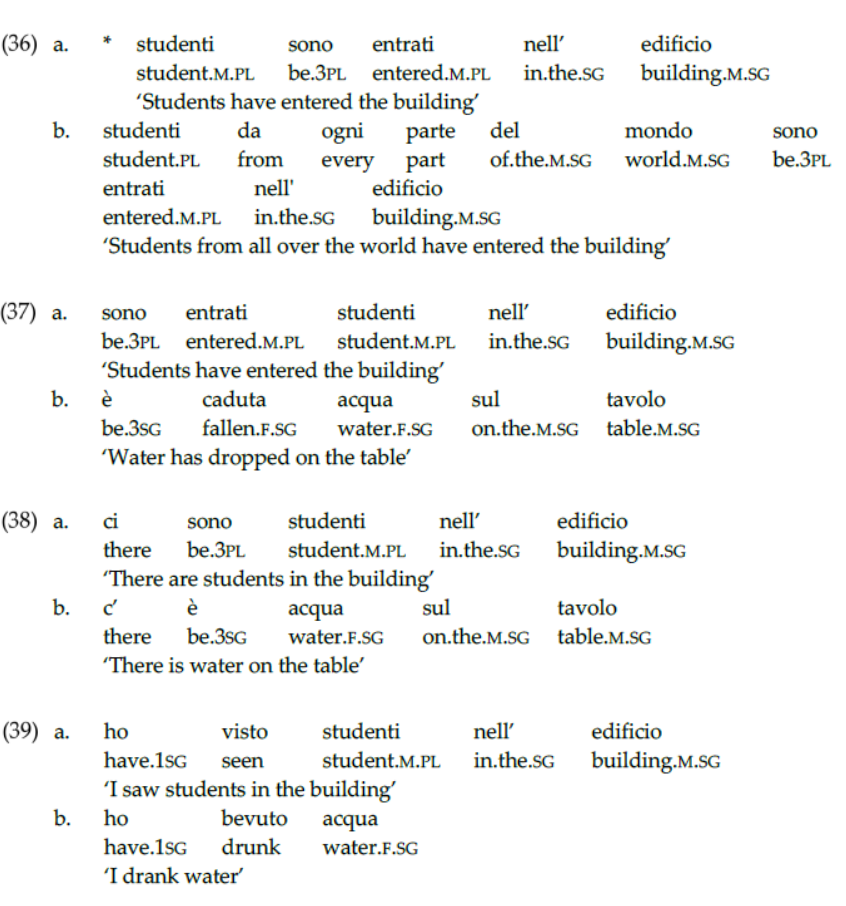
Table A6) that contain modified and unmodified plural nouns, singular count nouns, and mass nouns, in the following positions in non-negative